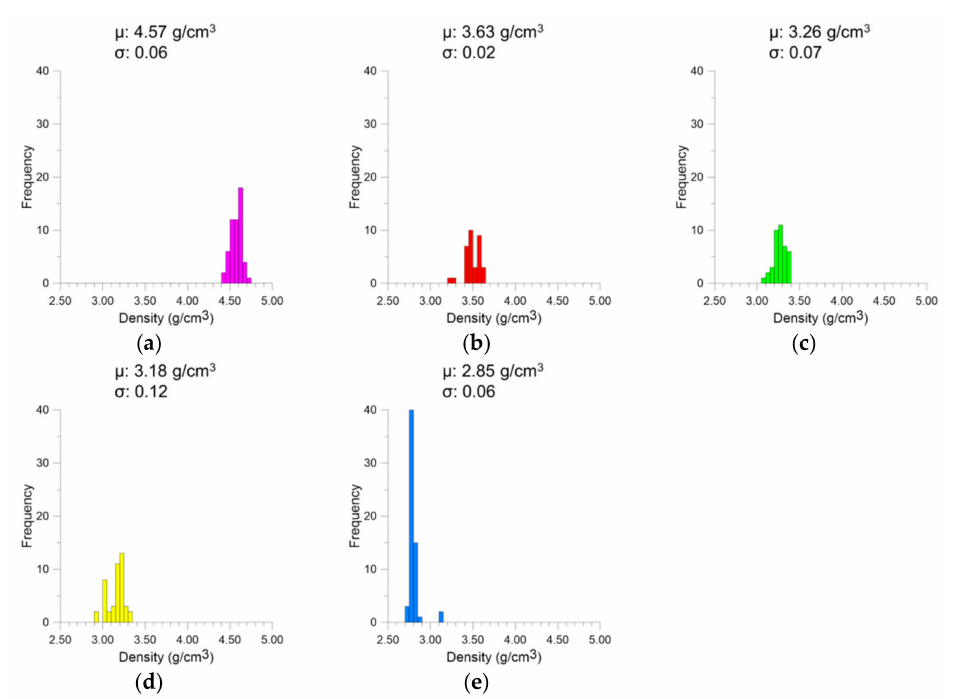
Figure 4. Histograms of density of rocks including mean ( µ ) and standard deviation ( σ ) of ( a ) under- ground ore, ( b ) discovered ore, ( c ) gabbro, ( d ) monzodiorite, and ( e ) quartz monzodiorite.